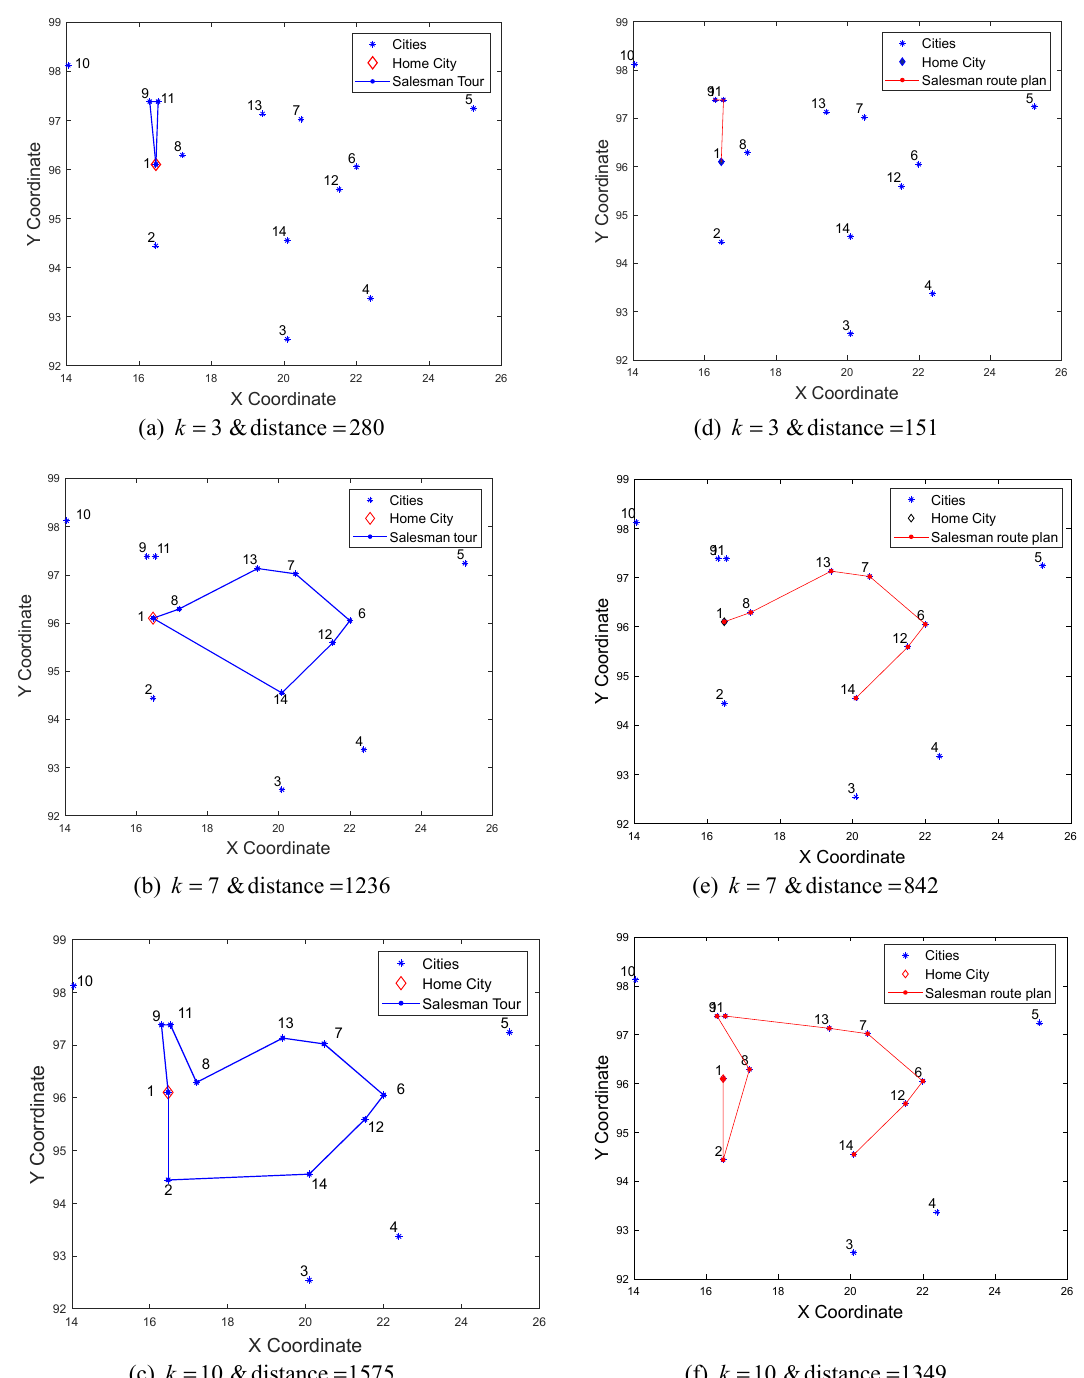
Fig.9. Best found TSSP (a, b, c) and OTSSP (d, e, f) solutions by proposed GA on burma14 with distinct k